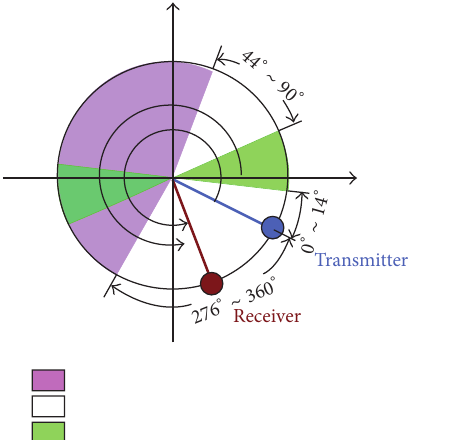
Figure 7: The unit location distribution of GEOSAR and UAVSAR. To assure the high resolution of range and azimuth, the range value of Ψ is drawn in Figure 7. A unit circle represents the position projection of transmitter and receiver in xOy ≤ 45 ∘ , GEO-UAV BiSAR configuration can show plane. If 𝜃 𝑟 in high-resolution ability in the content of Ψ ∈ area 2 and area